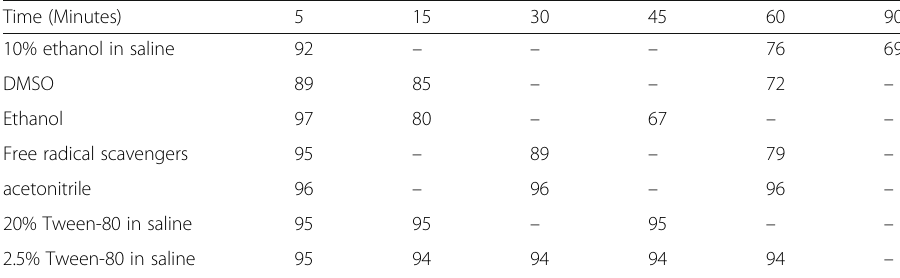
Table 2 Stability of [ 18 F] 5 assessed in several formulation solutions; N = 2 for each time point